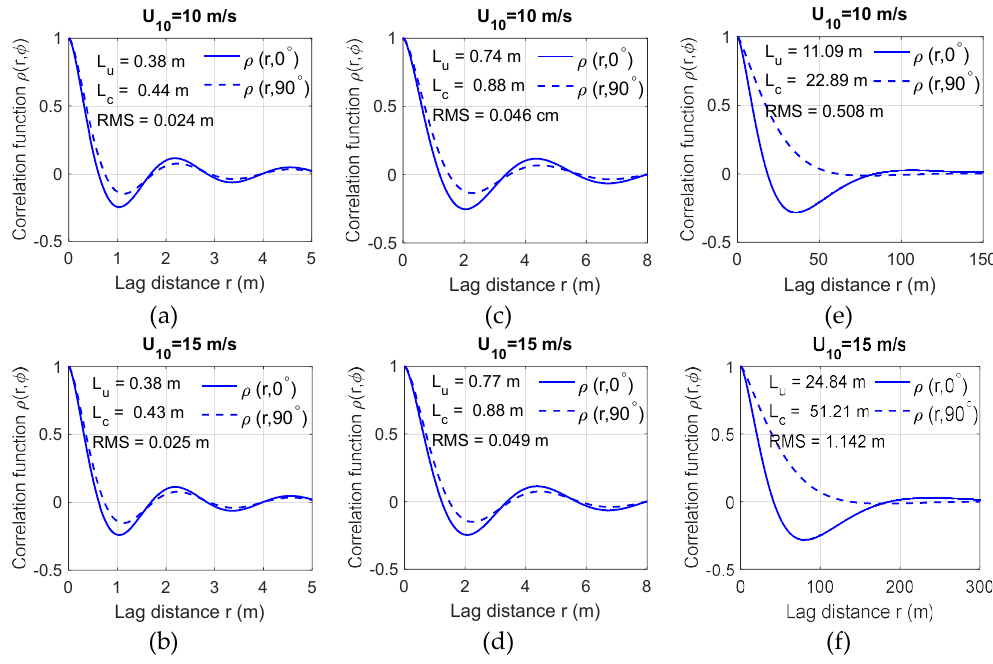
Figure 2. The normalized correlation functions and roughness parameters (RMS height and correlation length Lu, Lc in upwind and crosswind directions) generated by different wave spectral components ke based on Apel spectrum model at L-band (1.26 GHz) for wind speeds of 10 m/s and 15 m/s, respectively. ( a )–( b ) k e ∈ [0.1* k , ∞); ( c )–( d ) k e ∈ [0.05* k , ∞); ( e )–( f ) k e ∈ (0,∞)).